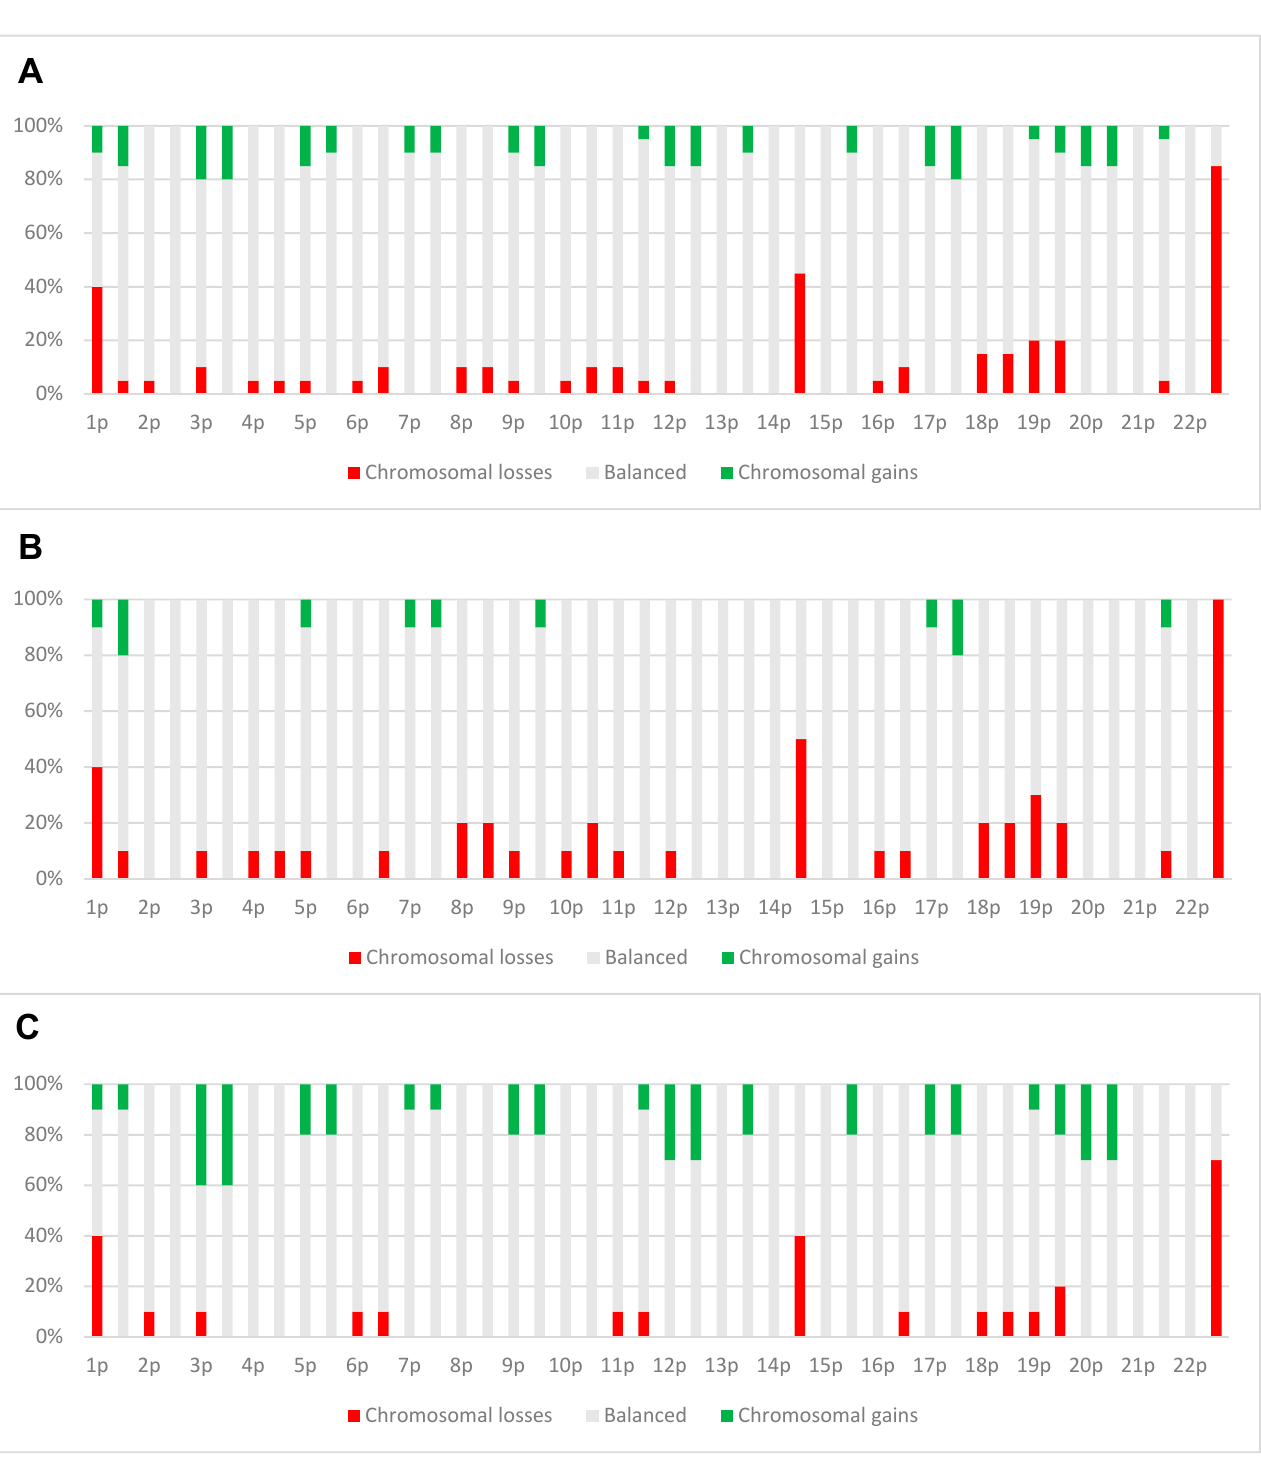
Figure 3. CNV profiles from methylation profiling data of all 20 cases ( A ) and profiles of cases distributed on group I ( B ) and group II ( C ), respectively.